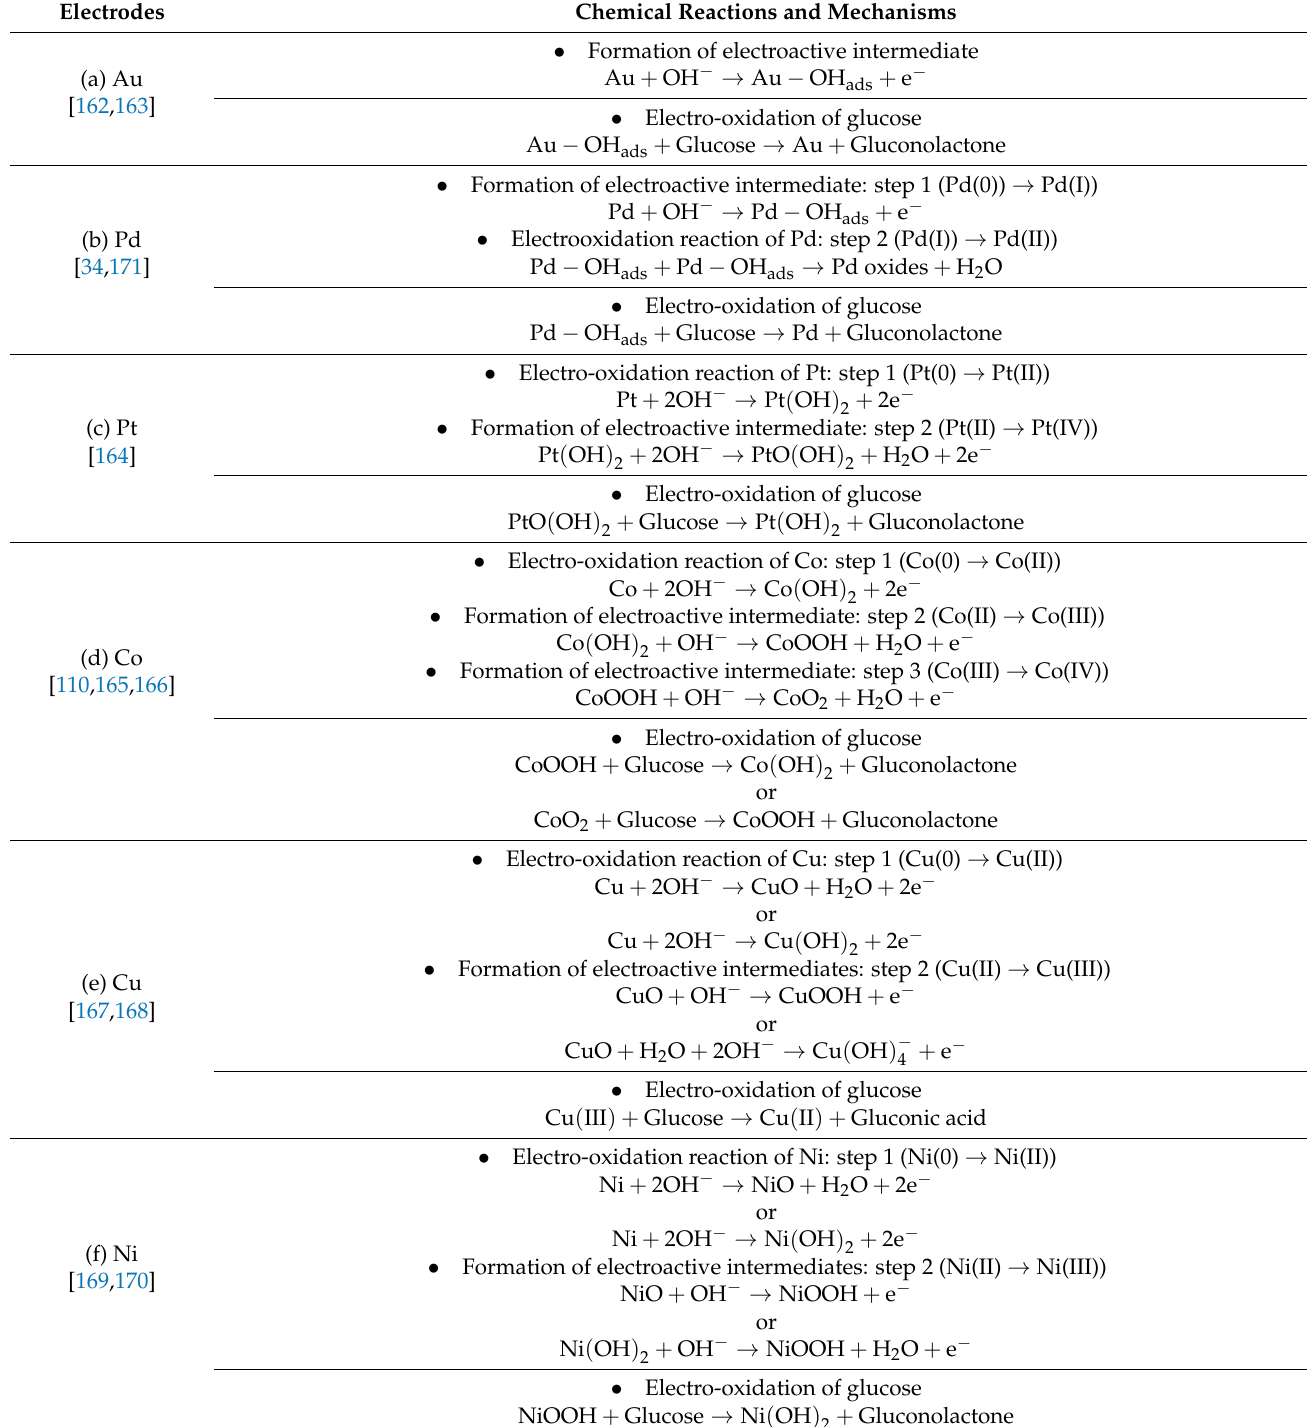
Table 1. The formation mechanisms of the electroactive intermediates and the electro-oxidation of glucose in the alkaline solution by the electroactive materials of the mono-metallic ( a ) Au [162,163], ( b ) Pd [34,171], ( c ) Pt [164], ( d ) Co [110,165,166], ( e ) Cu [167,168], and ( f ) Ni [169,170]. The general mechanisms for the formation of the electroactive intermediates and the electro-oxidation of glucose in the alkaline solution are also summarized and shown in ( g